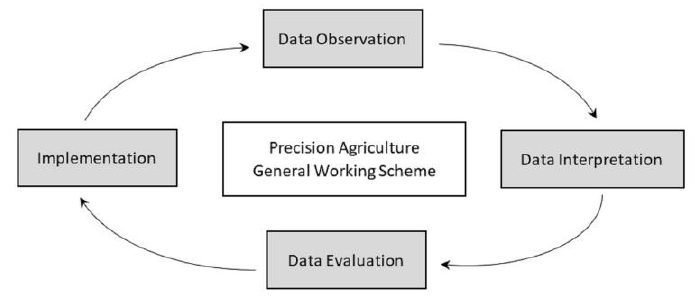
Figure 1. Precision agriculture (PA) general workflow [2].